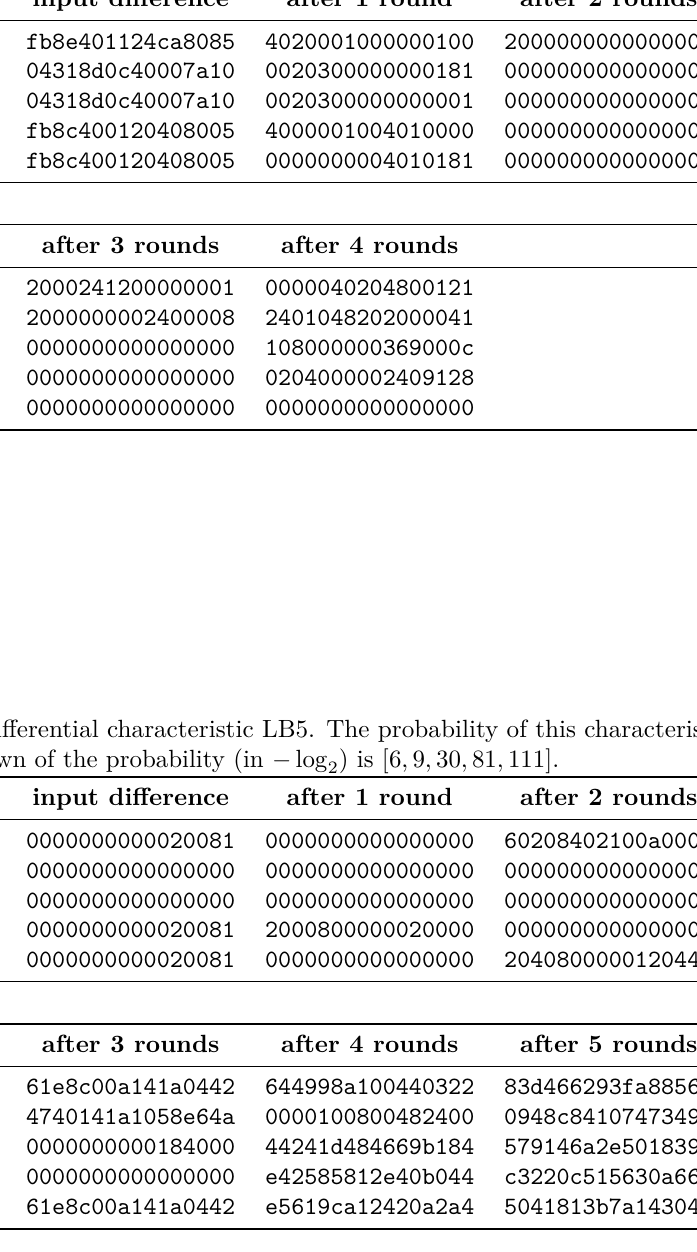
Table 17: Differential characteristic LB4.2. The probability of this characteristic is 2 − 141 . The breakdown of the probability (in − log